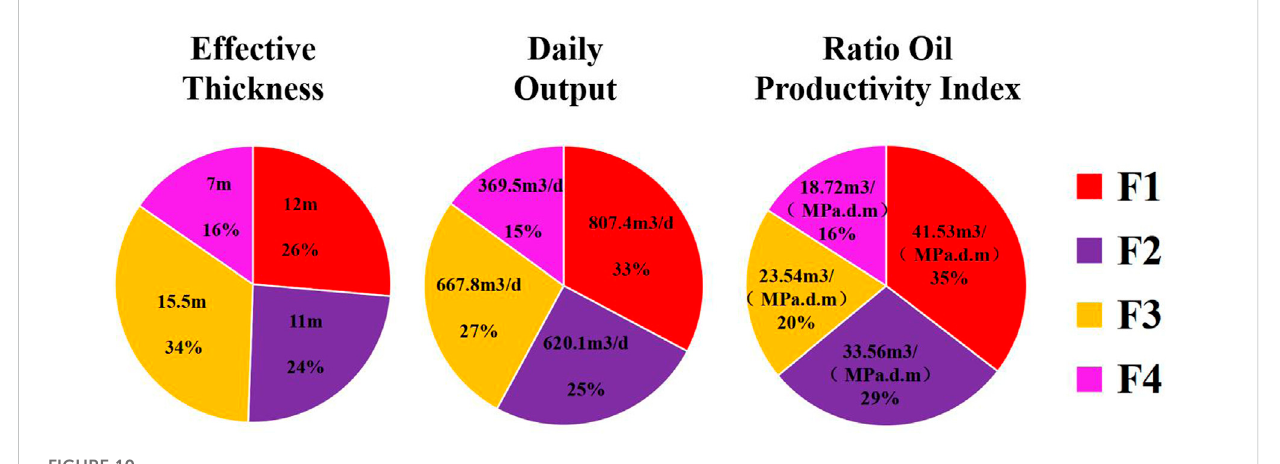
FIGURE 10 Analysis comparison of productivity capacity of different petrophysical